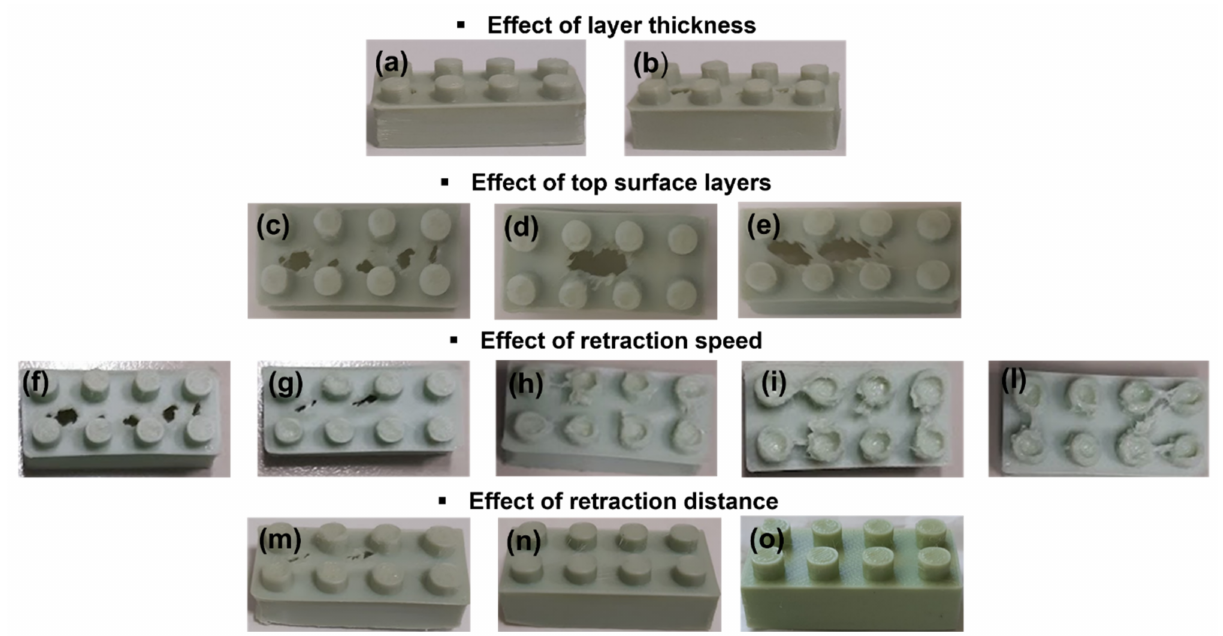
Figure 5. Effect of printing parameters on the final aesthetics of 3D piece made from recycled PLA corresponding to the conditions reported in Table 4 (( a )—layer thickness of 0.19 mm, ( b )—layer thickness of 0.09 mm, ( c )—top surface layers equal to 4, ( d )—top surface layers equal to 7, ( e )—top surface layers equal to 10, ( f )—retraction speed of 36 mm/s, ( g )—retraction speed of 27 mm/s, ( h )—retraction speed of 26 mm/s, ( i )—retraction speed of 24 mm/s, ( l )—retraction speed of 20 mm/s, ( m )—retraction distance of 1.2 mm, ( n )—retraction distance of 2.2 mm, ( o )—retraction distance of 2.7